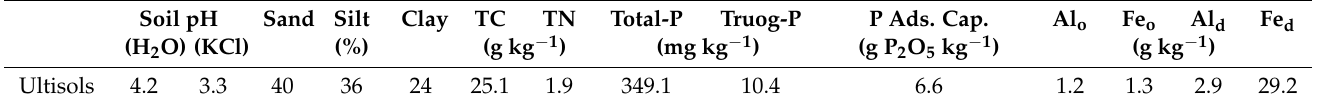
Table 1. Soils’ physico-chemical